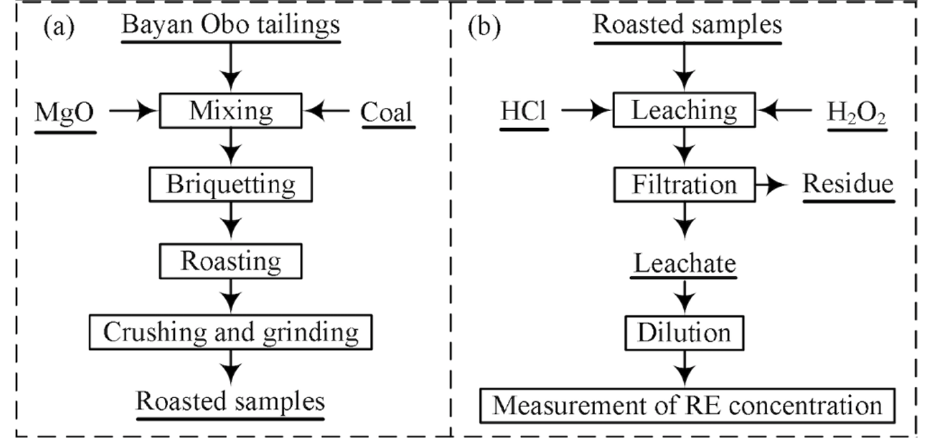
Figure 1. Flowchart of the experimental procedure. ( a ) roasting procedure, ( b ) leaching procedure.